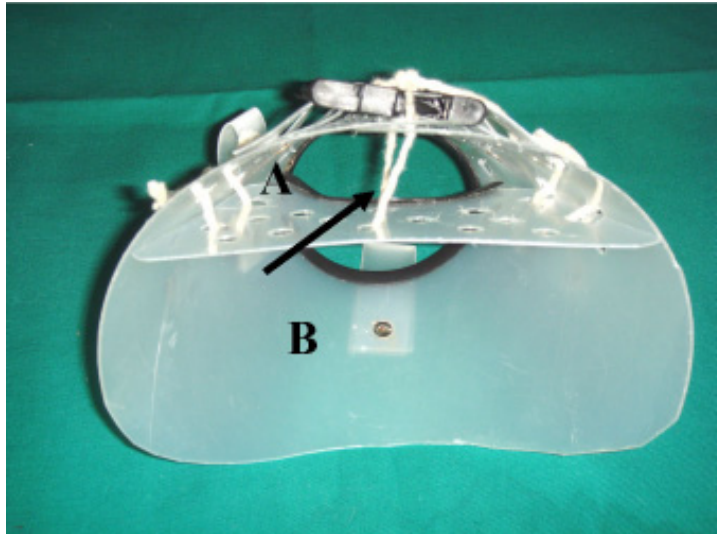
FIGURE 7 – Photograph of the front of the collar showing how it is dividing into two compartments, upper ( A ) and lower ( B ). Detail of the upper compartment for individual isolation of the ears, left and right, with a simple transversal brace with ties (black